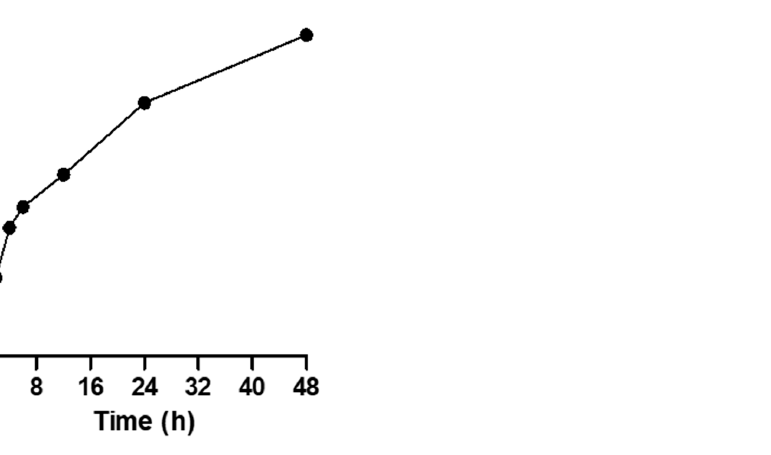
Figure 2. In vitro release of CAPE from CAPE-PEG–PLGA in phosphate-buffered saline (PBS) at 37 °C, pH 6.8 containing Tween 80 (0.5%) as a solubilizer .